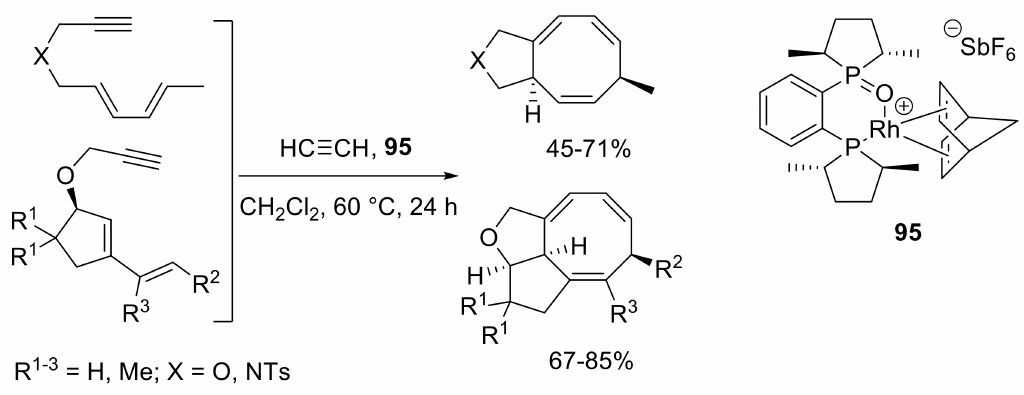
Scheme 52. Three-component cycloaddition with